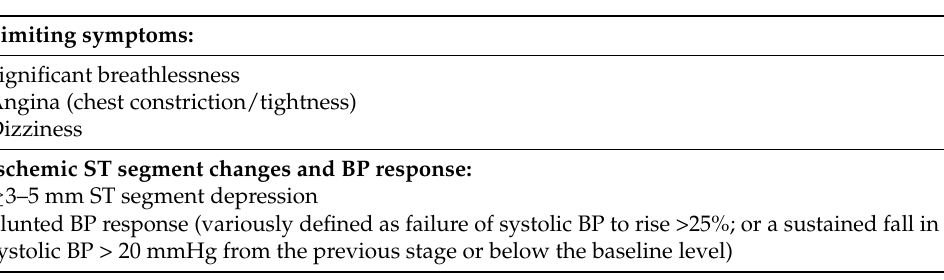
Table 2. Criteria of an abnormal exercise